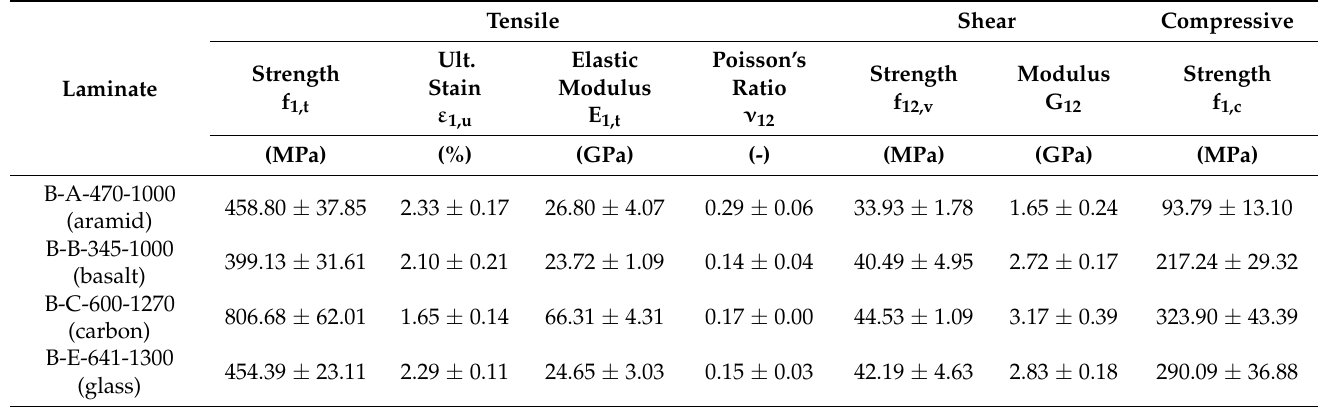
Table 3. Test results in the first stage of the research.